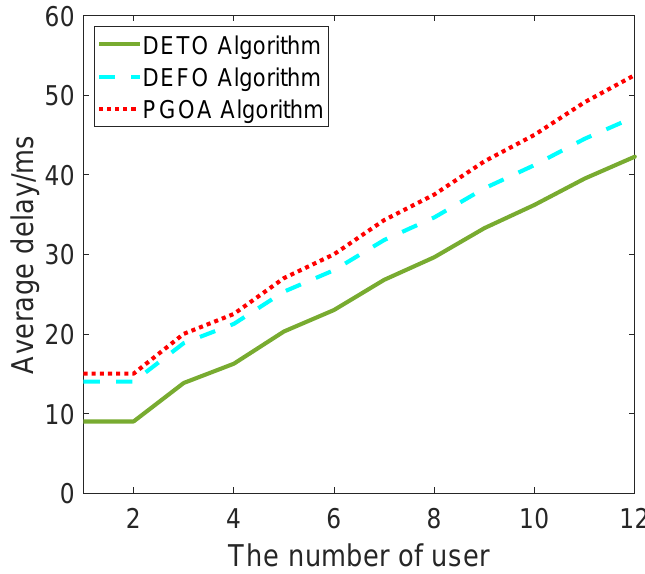
Figure 5. The delays for different